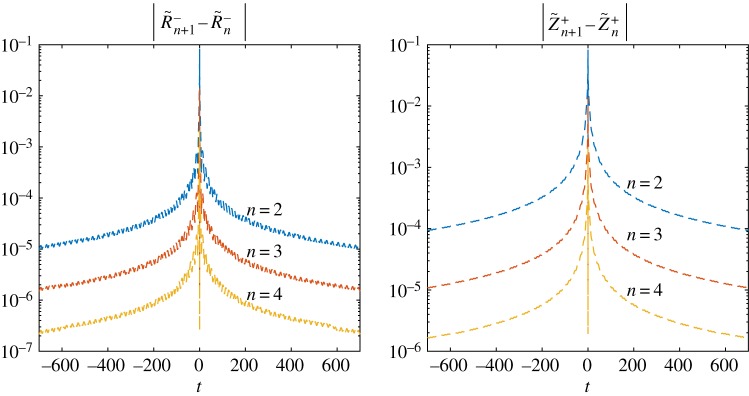
Reduction of the error with growing number of iterations for L* = 0.5. (Online version in colour.)